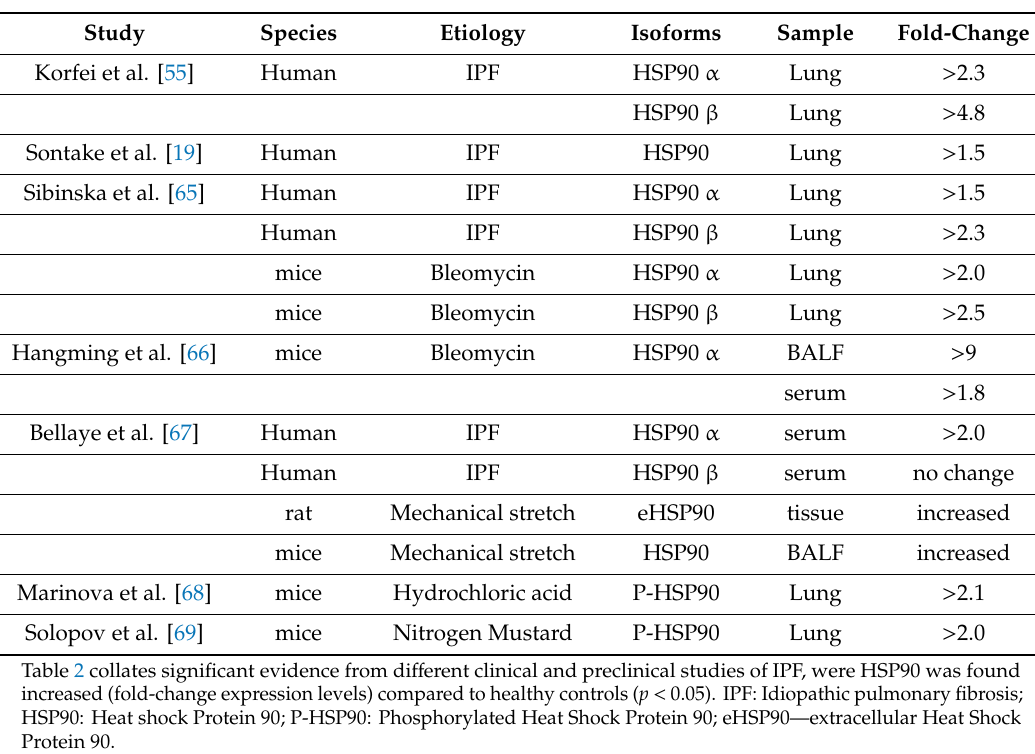
Table 2. Expression levels of HSP90 and its isoforms in clinical and preclinical studies of IPF. 2 Table 2 collates significant evidence from different clinical and preclinical studies of IPF, were HSP90 was found increased (fold-change expression levels) compared to healthy controls ( p < 0.05). IPF: Idiopathic pulmonary fibrosis; HSP90: Heat shock Protein 90; P-HSP90: Phosphorylated Heat Shock Protein 90; eHSP90 – extracellular Heat Shock Protein 90.